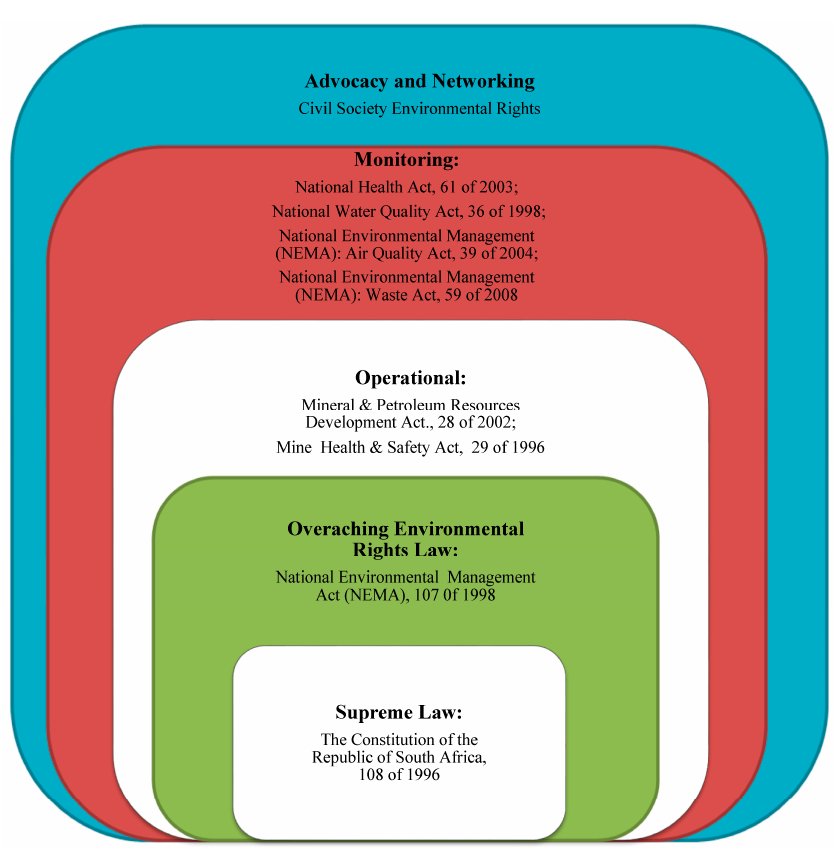
Figure 5. A proposed South African regulatory framework relevant to responsible tailings management.